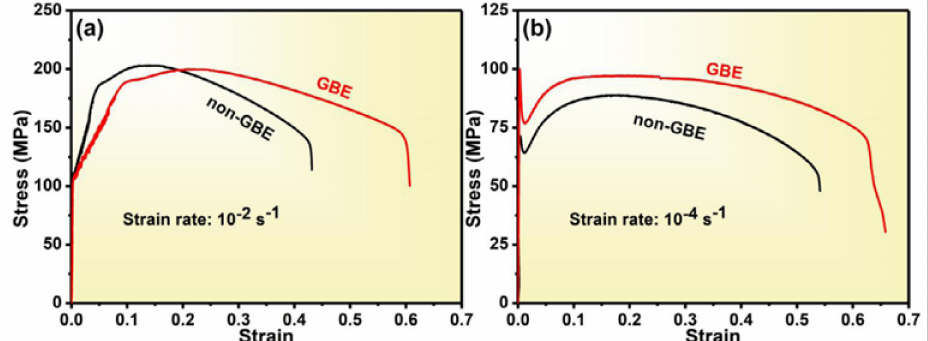
Figure 16. Comparison of tensile properties of non-GBE and GBE Cu-16 at%Al alloy samples at 723 K with strain rates: ( a ) 10 − 2 s − 1 and ( b ) 10 − 4 s − 1 . Reprinted with permission from ref. [19]. Copyright 2020